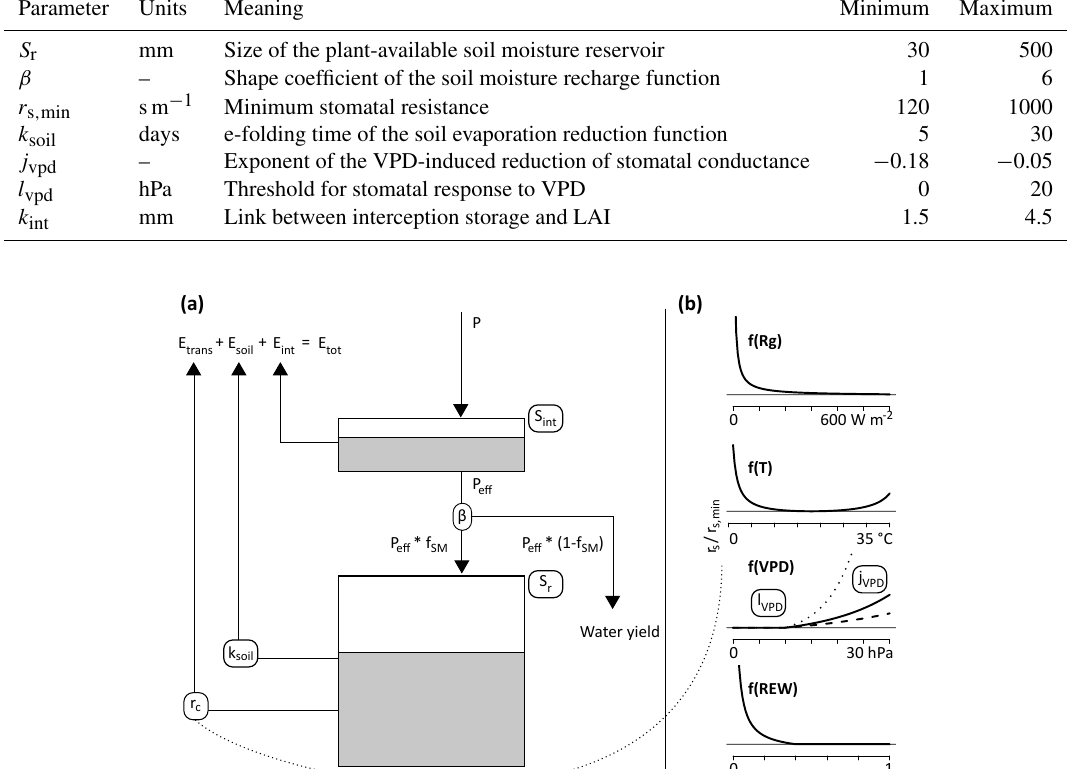
Figure B1. (a) Schematic representation of the water fluxes in the FORHYTM local water balance model. Incoming precipitation P first fills a canopy interception reservoir of size S int , from which water evaporates back to the atmosphere. Precipitation reaching the ground, P eff , is split between the rooting zone storage and runoff/groundwater recharge as a function of the parameter β and the current filling status of the rooting zone storage. This storage is depleted by soil evaporation and overstory transpiration. Soil evaporation is reduced from its potential value as a function of time since the last rainfall and the parameter k soil . Transpiration is controlled by the canopy resistance r c , i.e., stomatal resistance divided by LAI. (b) Relative increase in stomatal resistance as a function of radiation, air temperature, VPD and REW. When all functions are equal to one (optimal conditions), stomatal resistance is equal to r s , min